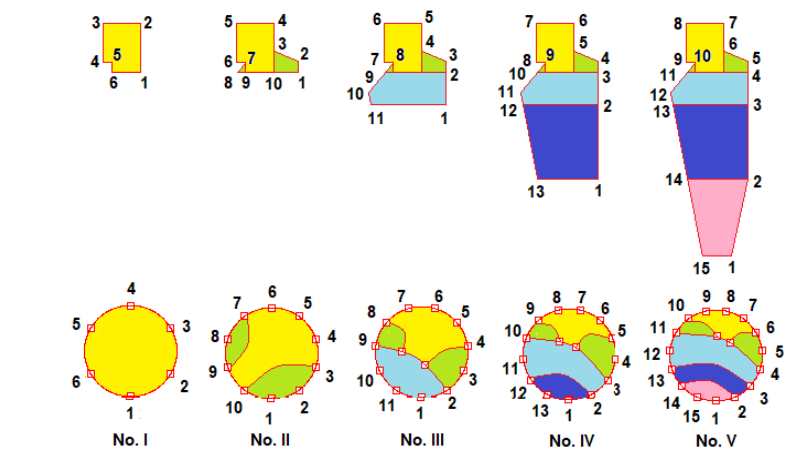
Figure 4 – The graphic visualization of the first graph model for five (I-V) flank-attacking plane shooting